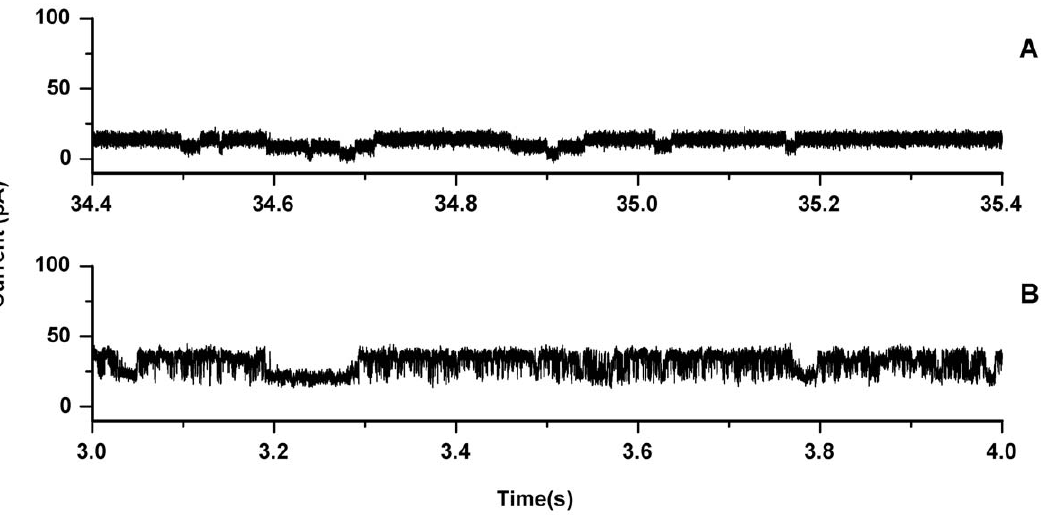
Figure 1. Recordings of channel events in a POPG planar lipid bilayer. The current was recorded with a transmembrane potential of 100 mV in the presence of 500 nM oligomeric a S. Current jumps were only observed if the membrane was formed and broken repeatedly. The top and bottom panels show the events observed in two separate experiments.